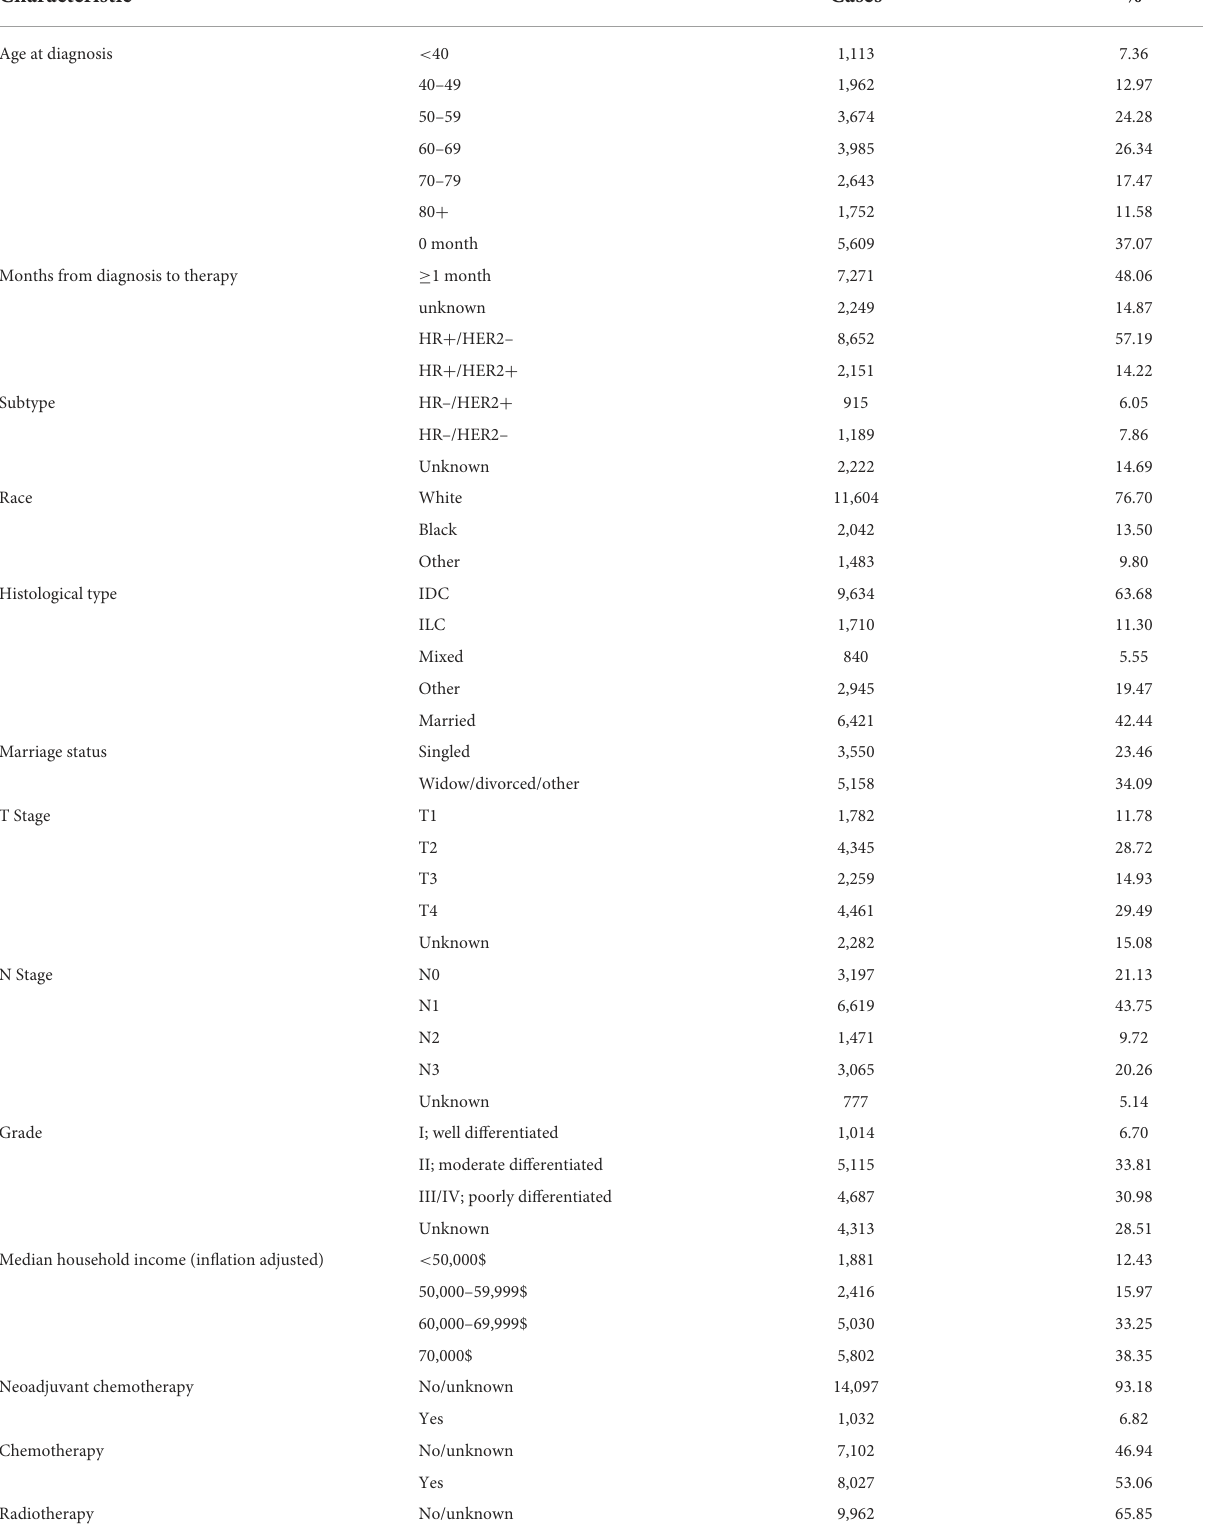
TABLE 1 Baseline characteristics of patients with bone metastatic breast cancer (BMBC) included from SEER data cohort.